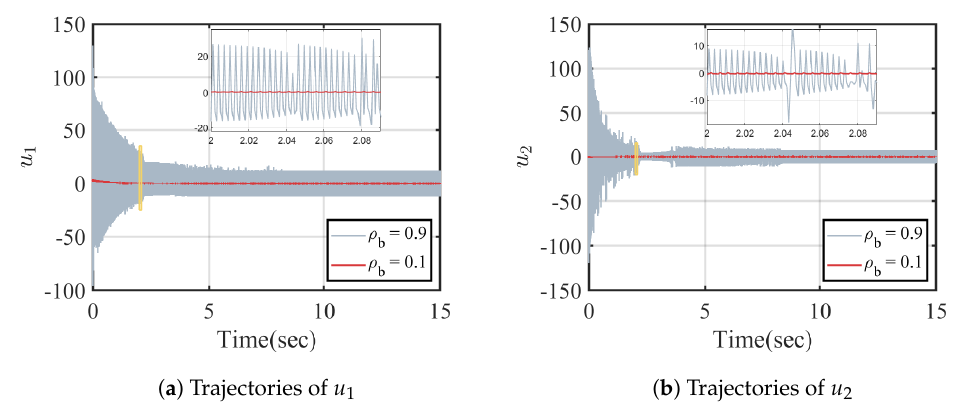
Figure 2. The control variable performance of the system controlled by cSMC in the case of ρ b = 0.9 (gray solid line) and ρ b = 0.1 (red solid